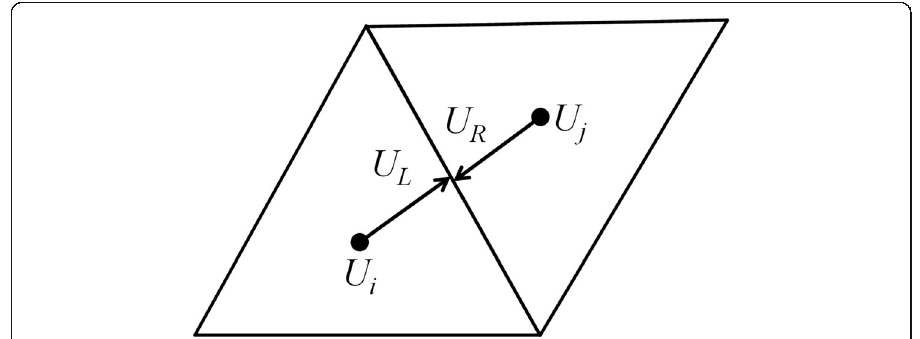
Fig. 1 Solution reconstruction of a control volume